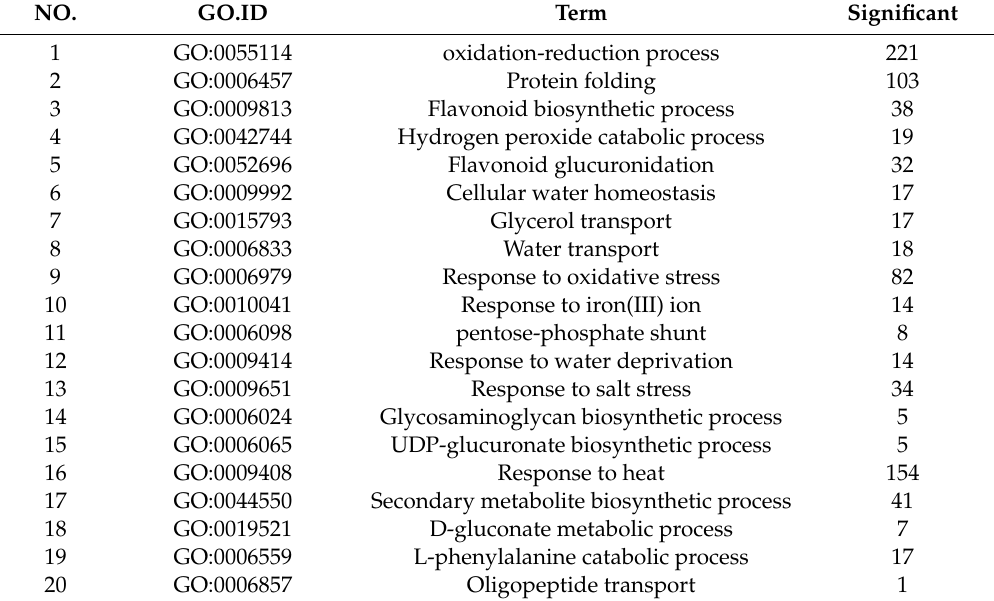
Table 3. Gene Ontology (GO) analysis of DEGs significantly annotated in the biological process (BP).